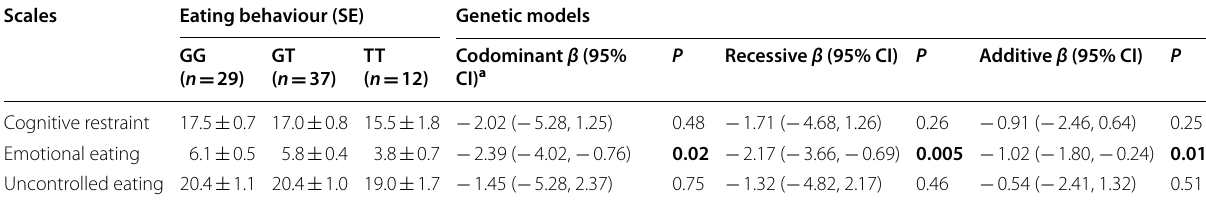
Eating behaviour phenotypes include cognitive restraint, emotional eating and uncontrolled eating. β beta-coefficient, SE standard error, n sample size a Only comparison of GG (reference) versus TT genotypes Table 3 Comparison of clinical variables according to rs1501299 genotypes